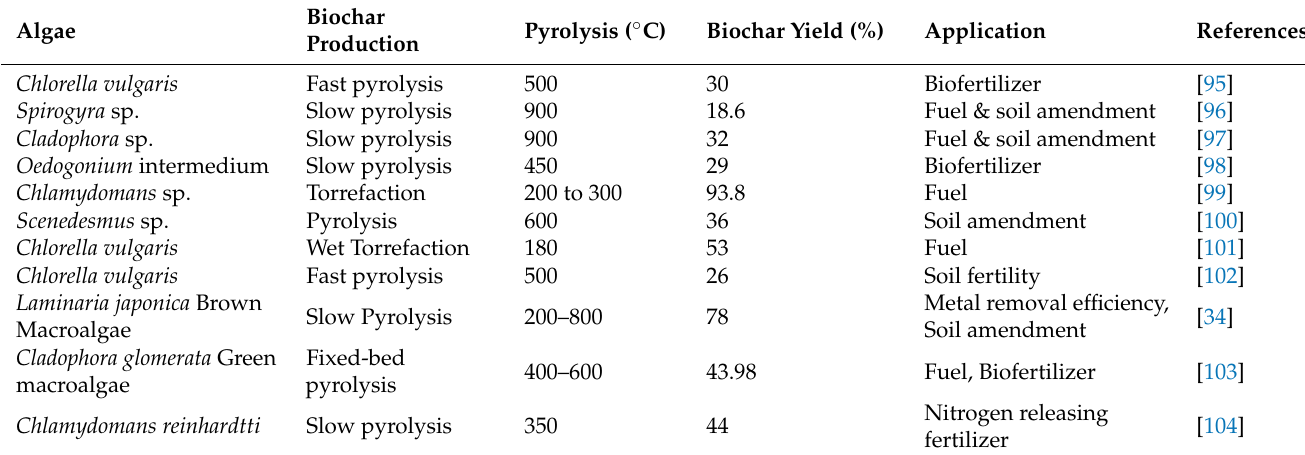
Table 2. Comparison of biochar yield from algae using different thermochemical